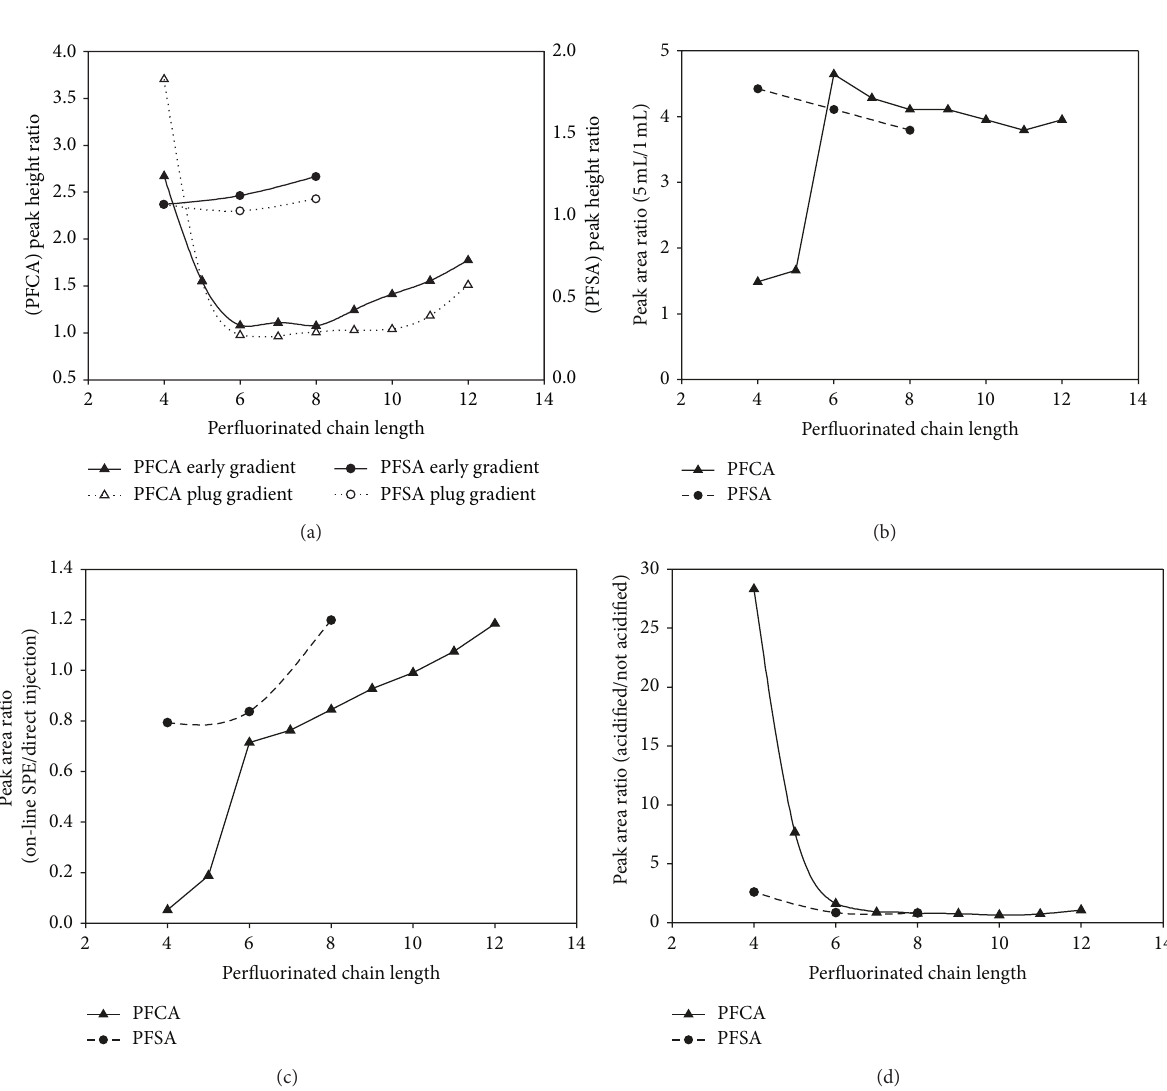
Figure 3: Development of the on-line SPE method. (a) Effect of different elution gradients, “plug gradient” or “early gradient” compared with “unchanged gradient,” on the analyte peak height; injection of 5mL of acidified aqueous standard at 200 ng/L. (b) Effect of the sample volume on the peak area; injection in “early gradient” mode of aqueous standard at 200 ng/L. (c) Extraction efficiency of the 5 mL on-line SPE injection volume; on-line SPE injection in “early gradient” mode of 5 mL of aqueous standard at 200 ng/L and direct injection of 25 𝜇 L of aqueous standard at 40 𝜇 g/L. (d) Effect of acidification of the sample on the peak area; injection in “early gradient” mode of aqueous standard at 200